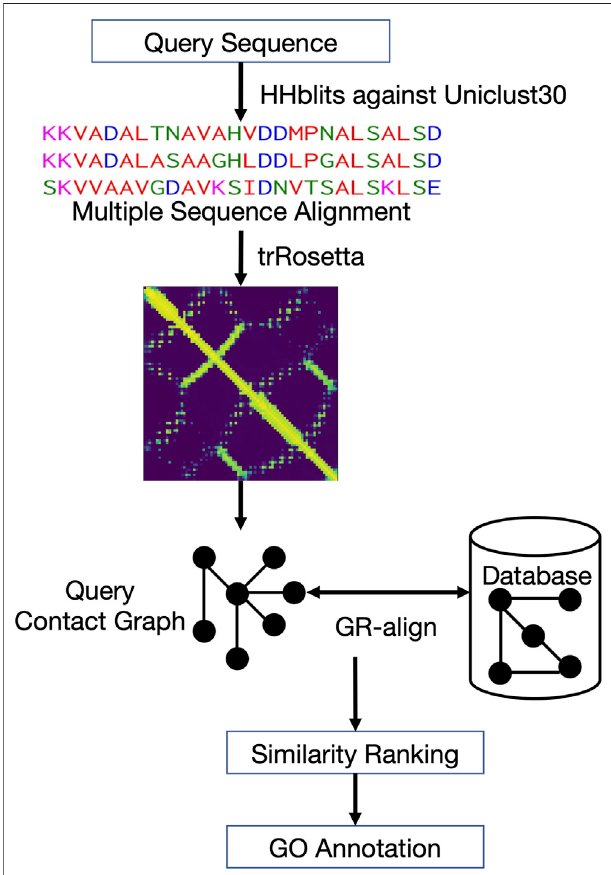
FIGURE 1 | Overview of ContactPFP. From an input protein sequence, residue-residue contact information is predicted with trRosetta, which is represented as a graph. Then, the graph is compared with contact map graphs in a database using GR-Align. Proteins in the database are sorted by graph similarity to the query and GO terms are extracted from top